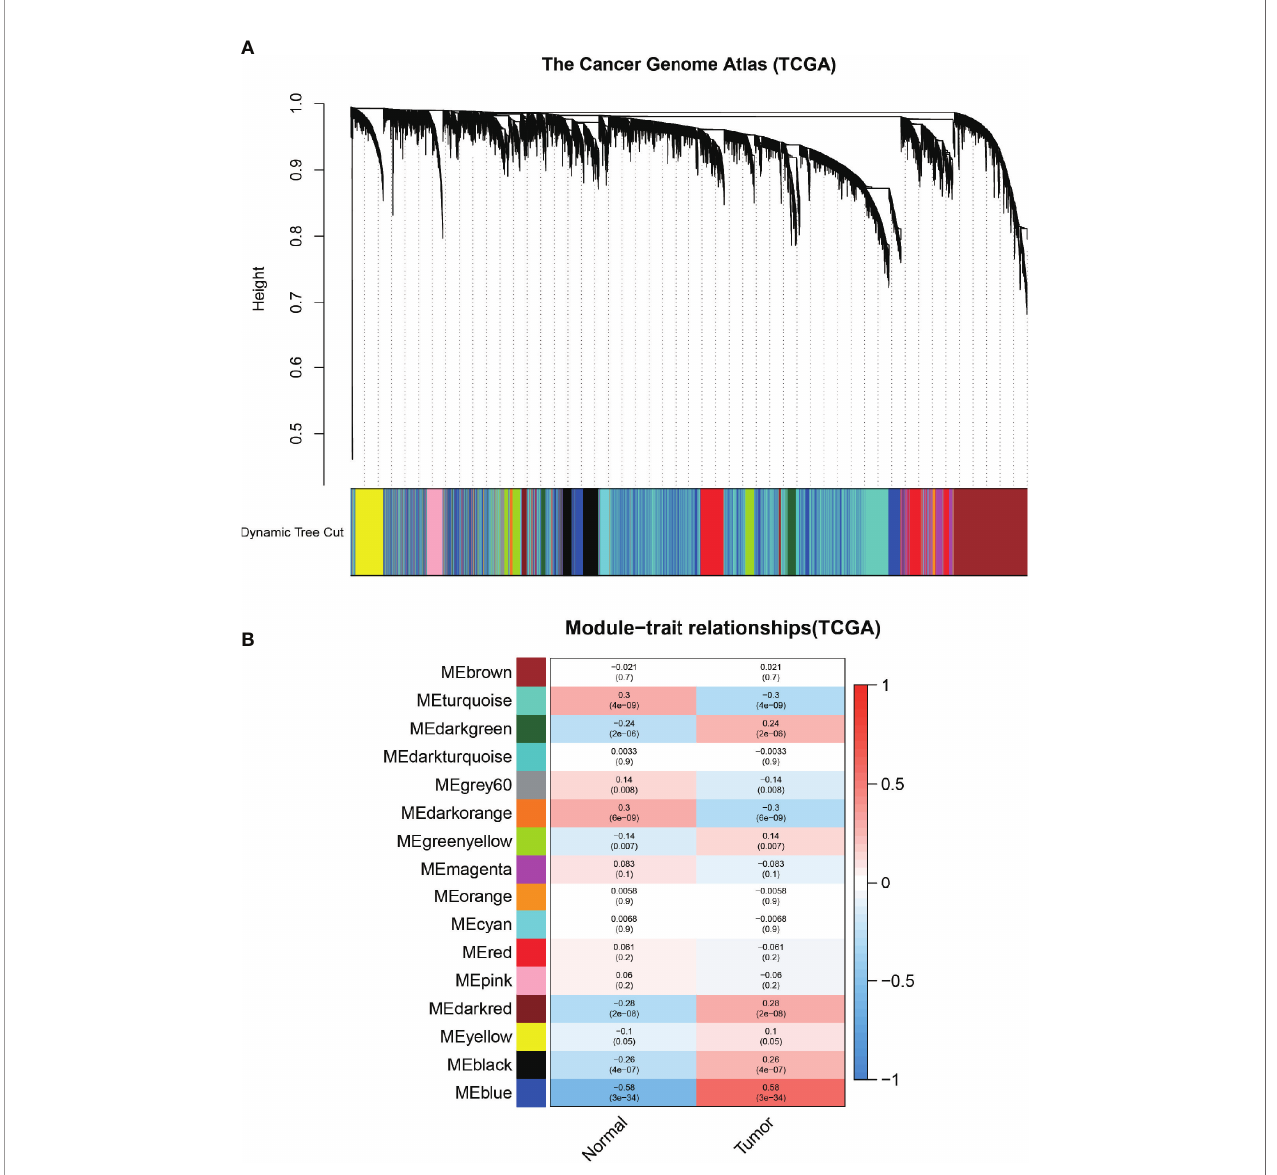
FIGURE 3 | Results of weighted gene co-expression network analysis. (A) Diagram, representing the dynamic shearing tree, divides the co-expressed genes into different modules. (B) -plot, indicating the Person correlation coef fi cient of each module with normal and tumor